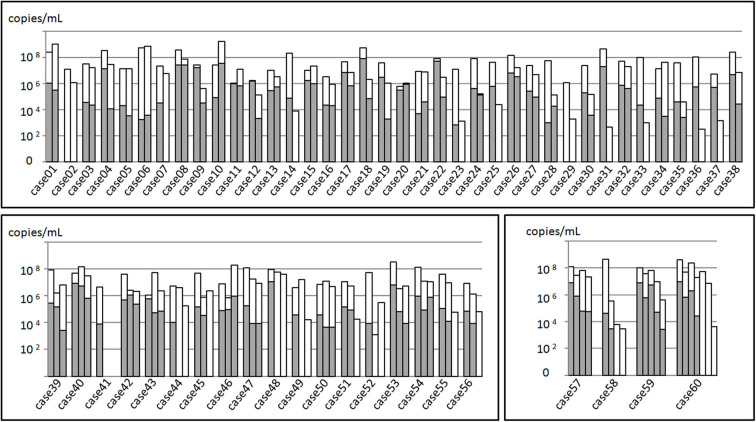
Mycoplasma pneumoniae DNA quantitation analysis of 150 BALF samples from 60 patients. The total height of the column including the white and gray parts represented the total M. pneumoniae DNA load of the samples. Gray part represented the DNA load of viable M. pneumoniae. In the upper part, 38 patients received sampling twice, while in the left inferior part, 18 received sampling thrice. In the right inferior part, 4 received at least three sampling.